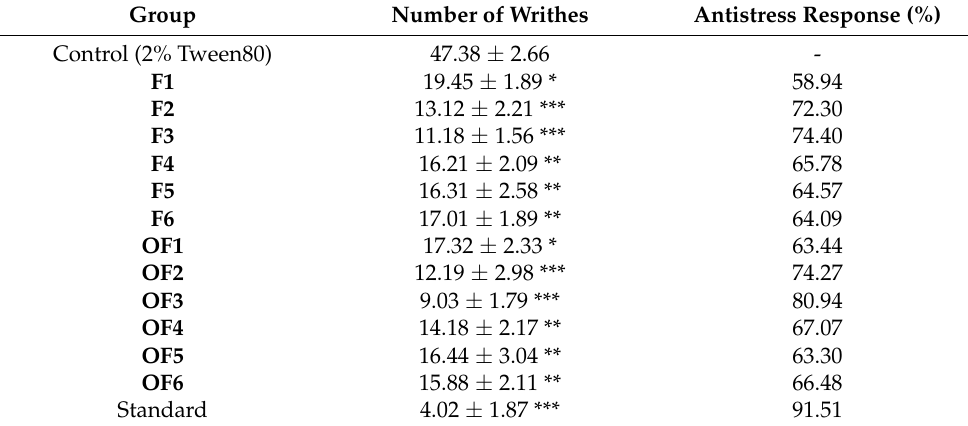
Table 1. Effect of flavonoids on chemical induced stress test.